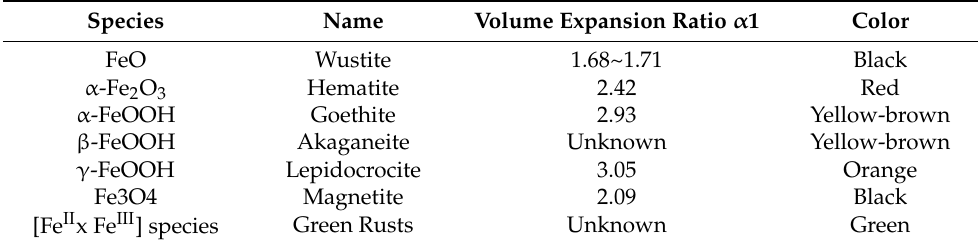
Table 1. Type and properties of corrosion products in reinforced concrete structures.